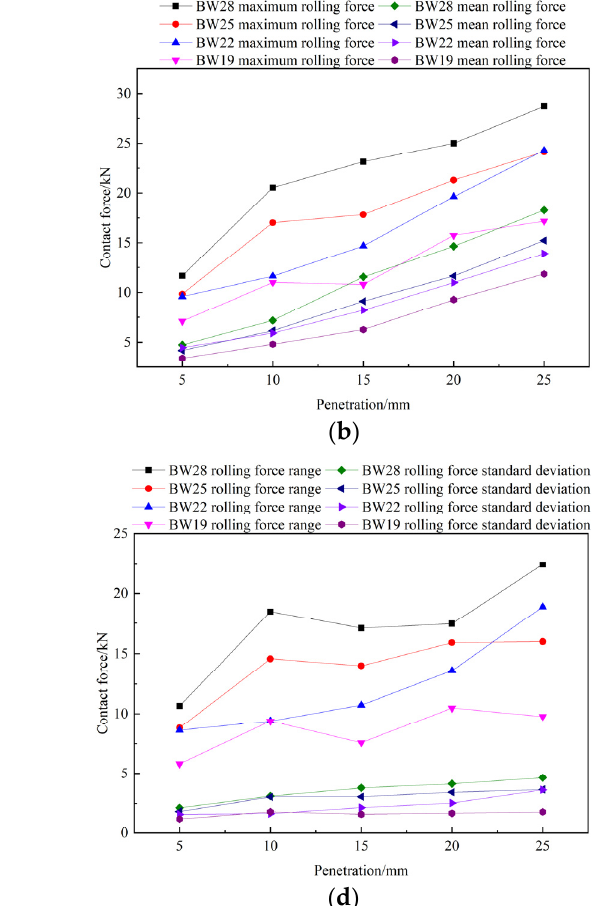
Figure 19. The contact force of BF 5mm disc cutter with different blade widths. ( a ) Normal force; ( b ) Rolling force; ( c ) Range and STD of normal force; ( d ) Range and STD of rolling force.